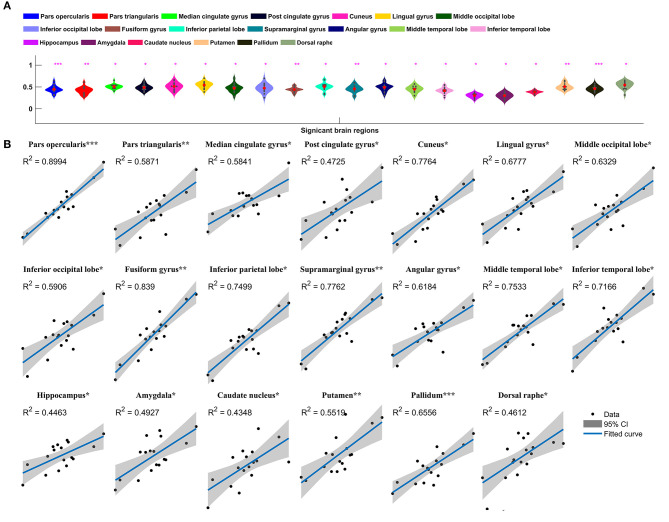
Insula-to-cortex metabolic covariance network in a group of individuals with insular epilepsy. (A) Boxplots showing FDG uptake values (P < 0.05, Bonferroni corrected). Solid red circles denote mean values and gray dots denote individuals. (B) Scatter plots showing the covariance across epileptic individuals in FDG uptake values between the insula and other regions. Solid black circles denote individuals. The horizontal axis shows normalized FDG uptake values for the insula, the vertical axis corresponds to the region indicated in the title. For each scatter plot, the blue line denotes the line of best fit, and shading denotes the 95% confidence interval. *P < 0.05, **P < 0.01, ***P < 0.001.